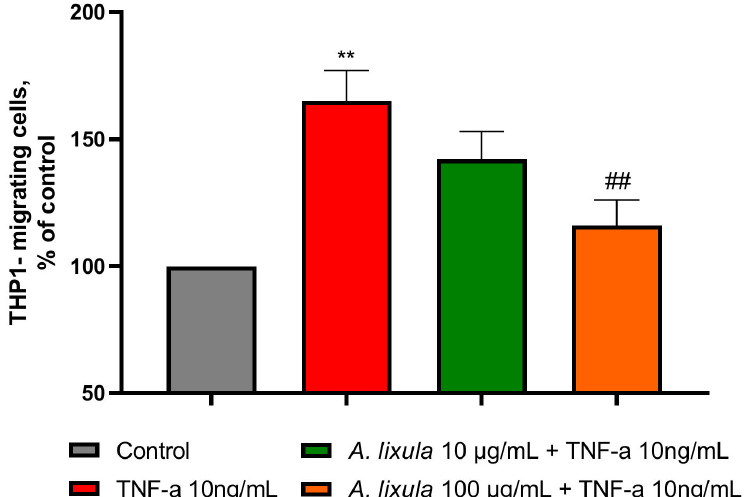
Figure 5. Effect of A. lixula extract on TNF- α -induced chemiotaxis of monocytes. HMEC-1 were treated with A. lixula extract for 4 h at the concentration indicated, and then either treated with 10 ng/mL TNF- α or left untreated for 18 h. Culture medium was collected and added to the lower chamber of a Boyden chamber. THP-1 were added to the upper chamber. Migrated THP-1 cells were then measured by the MTT assay. Data (means ± S.D., n = 3) are expressed as percent of untreated